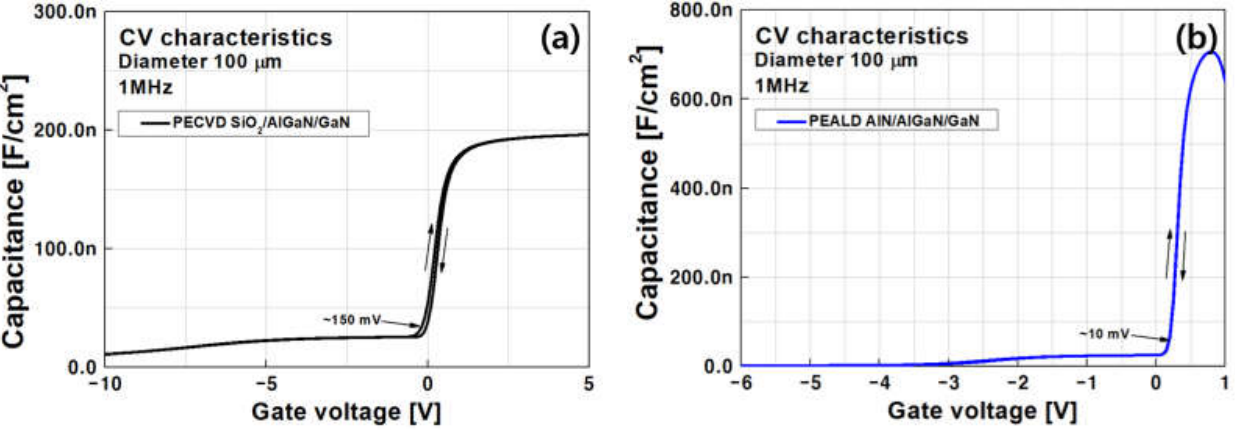
Figure 10. C-V hysteresis characteristics measured at 1 MHz for ( a ) PECVD SiO 2 /AlGaN/GaN and ( b ) PEALD AlN/AlGaN/GaN structures.